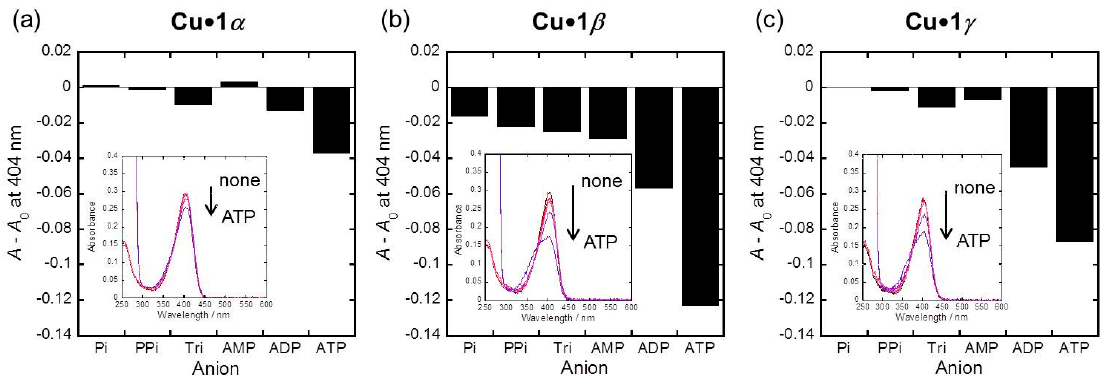
Figure 3. UV-Vis responses of ( a ) Cu·1 α ; ( b ) Cu·1 β ; and ( c ) Cu·1 γ in the presence of phosphoric acid derivatives in water, pH 6.4 adjusted by PIPES/NaOH buffer, at 25 °C. [ 1 α , 1 β , or 1 γ ] = 0.010 mM, [Cu(NO 3 ) 2 ] = 0.010 mM, [phosphoric acid derivative] = 1.0 mM.